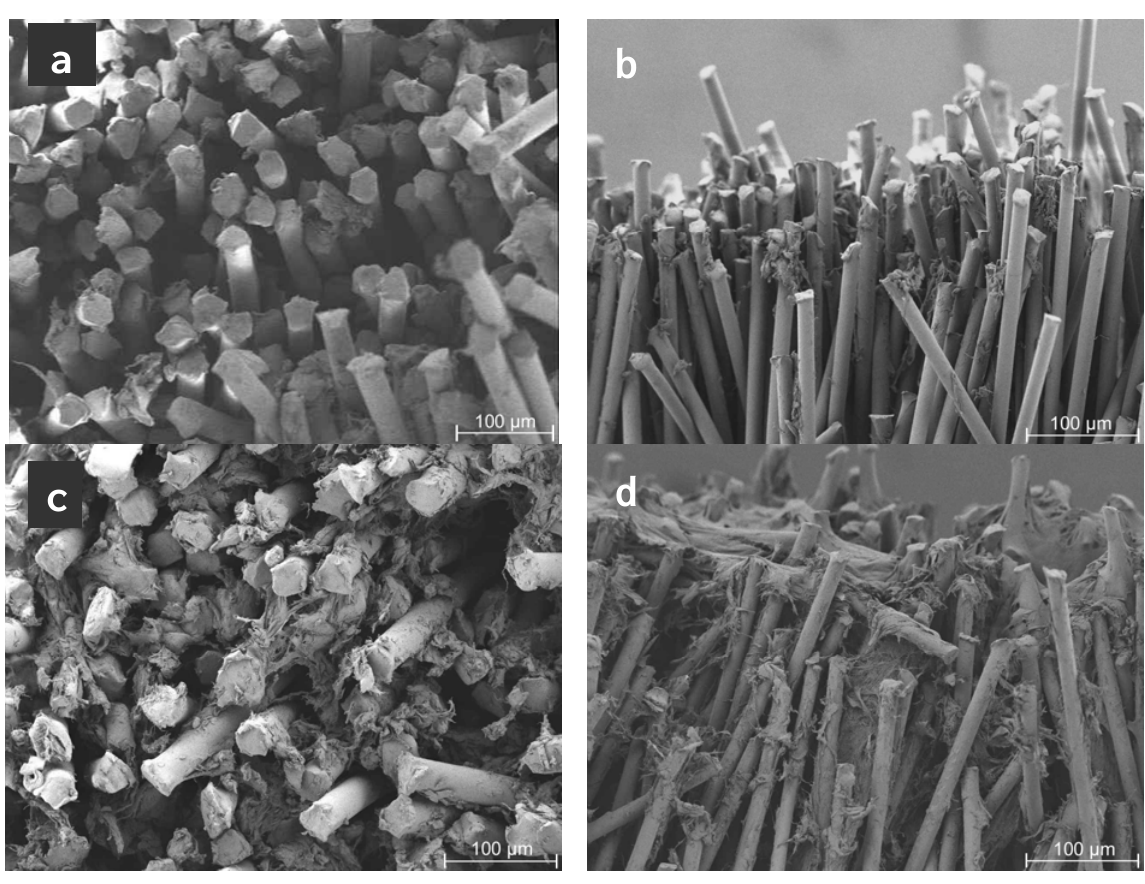
Figure 8. Scanning electron microscopy images of cell seeded samples with 1 mm fiber length (flocking time: 15 sec) at different time points of culture showing that flock scaffolds support proliferation of human mesenchymal stem cells. ( a ) Top view 7 days after seeding; ( b ) Longitudinal view day 7; ( c ) Top view 21 days after seeding; ( d ) Longitudinal view day 21. Magnification: Top views 200×; longitudinal views